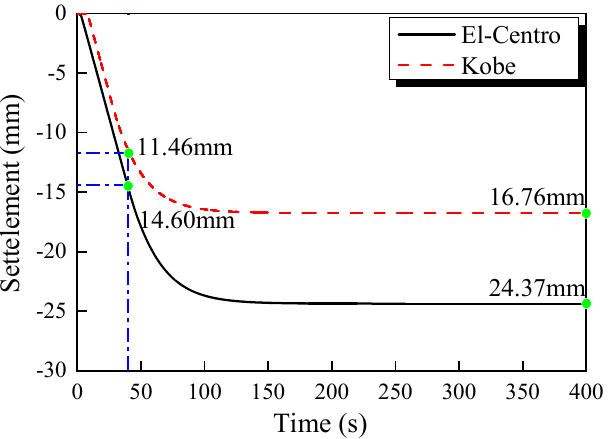
Figure 13. Time history of settlement at the ground surface under the El-Centro and Kobe Motion.